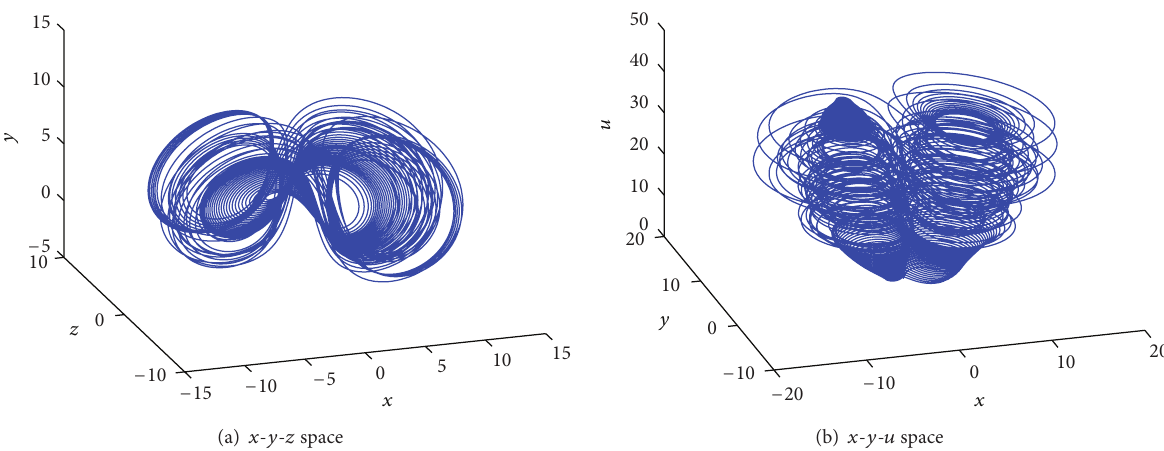
Figure 8: Phase portraits of system (3) for 𝑞 1 = 0.98 , 𝑞 2 = 0.89 , 𝑞 3 = 0.97 , 𝑞 4 = 0.78 , 𝑎 = 3 , 𝑏 = 0.3 , 𝑐 = 0.8 , and 𝑑 = 0.1